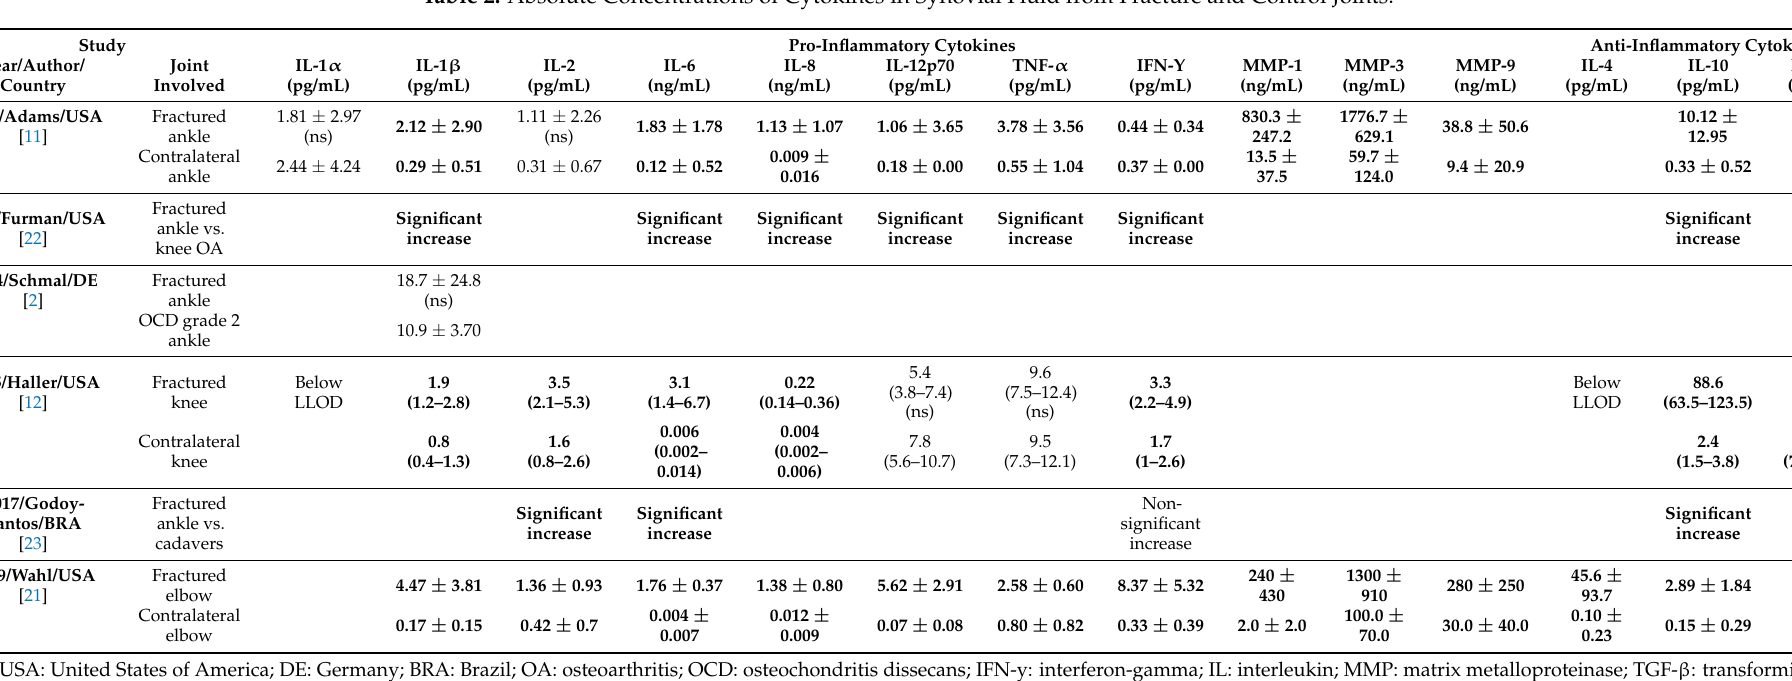
Table 2. Absolute Concentrations of Cytokines in Synovial Fluid from Fracture and Control